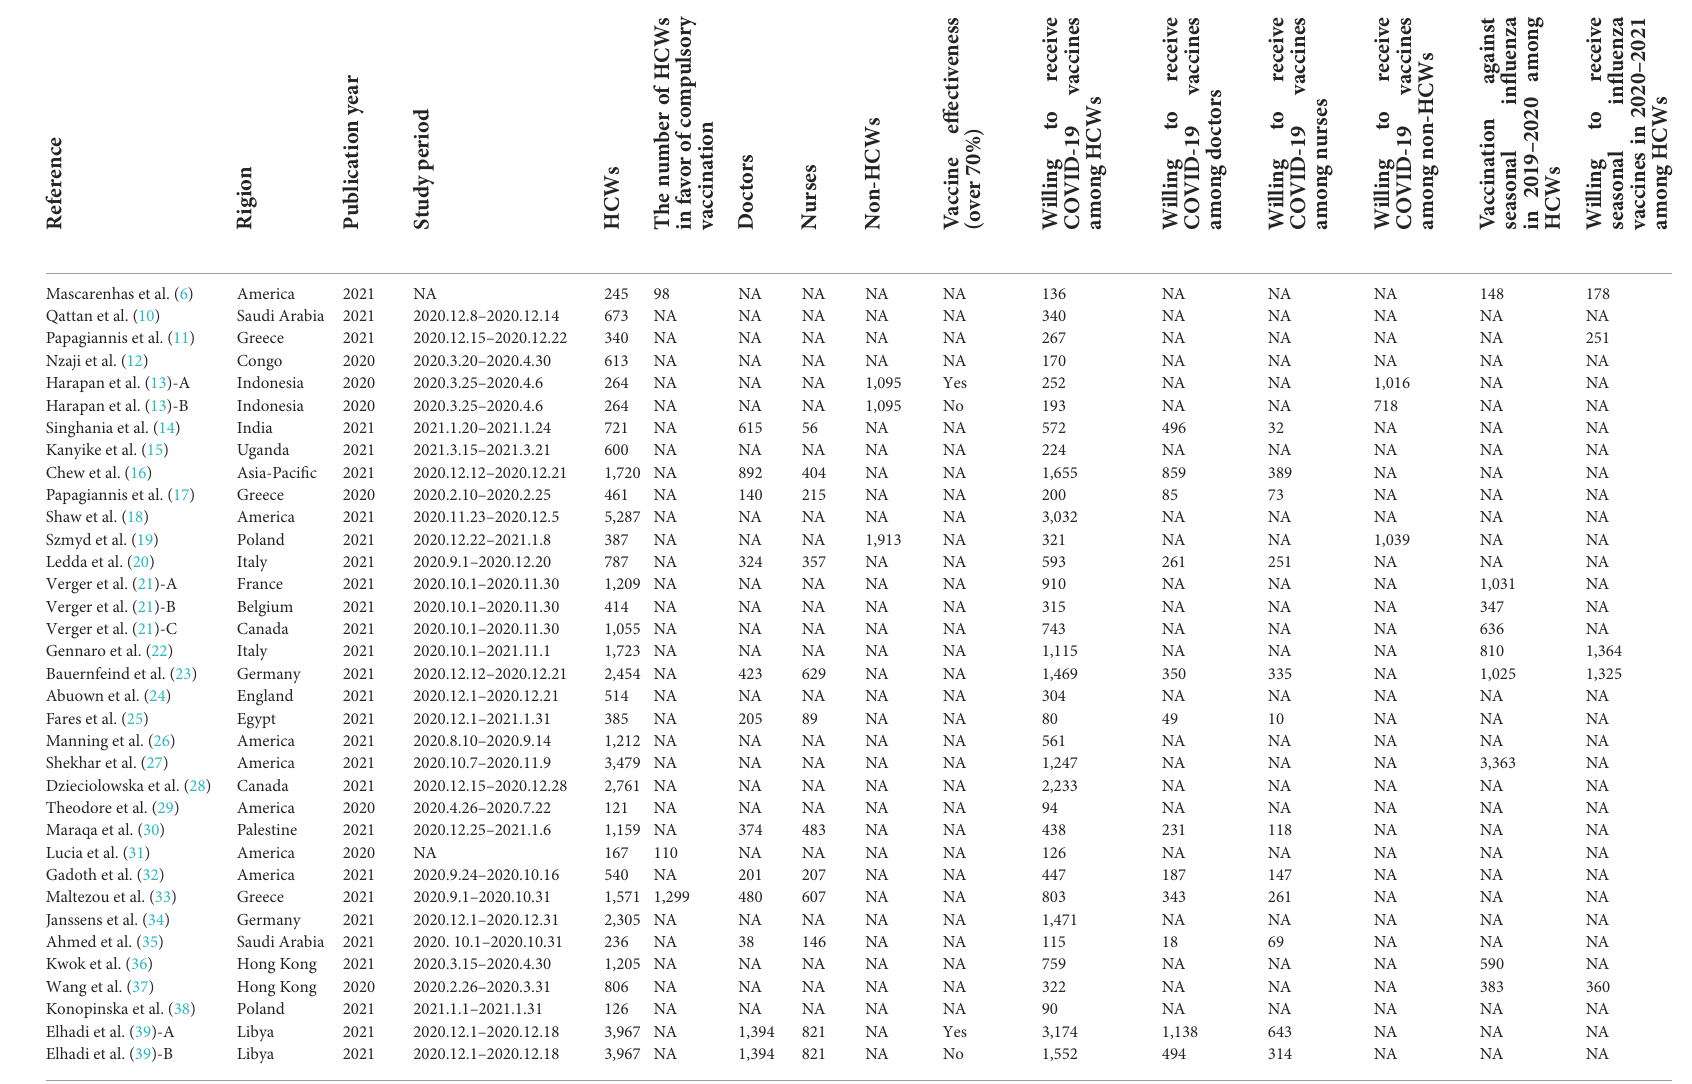
TABLE 1 The characteristics of HCWs and